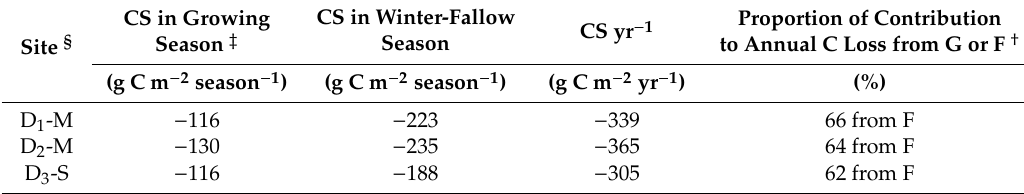
Table 6. Seasonal CS or C loss and their contribution to annual CS or C loss.